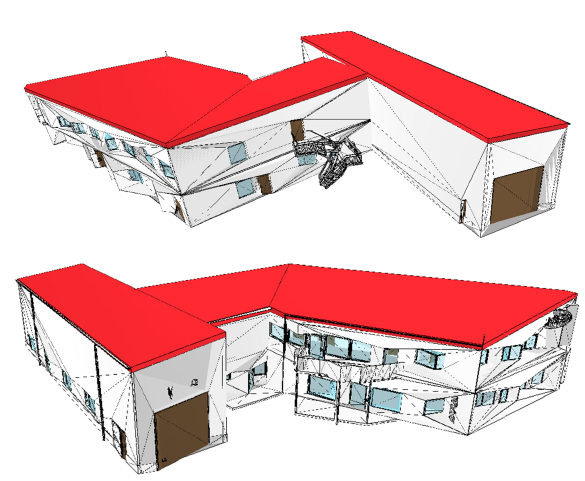
Figure 6. Converted model IFC to CityGML in one of the attempts most directed to the achievement of a consistent representation with 3D city models practice, by means of a specific workflow in